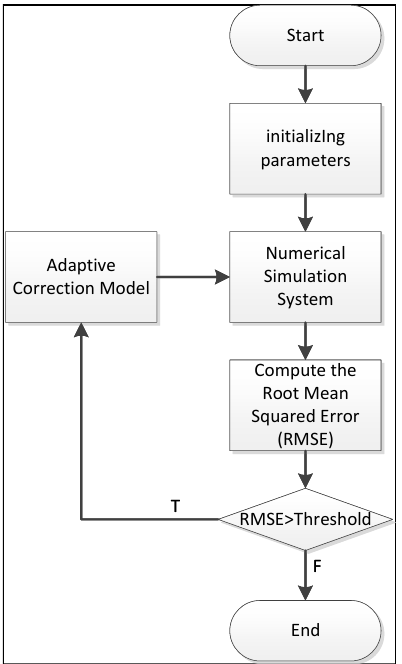
Figure 2. Flow chart of the parameter spatialization and adaptive modification